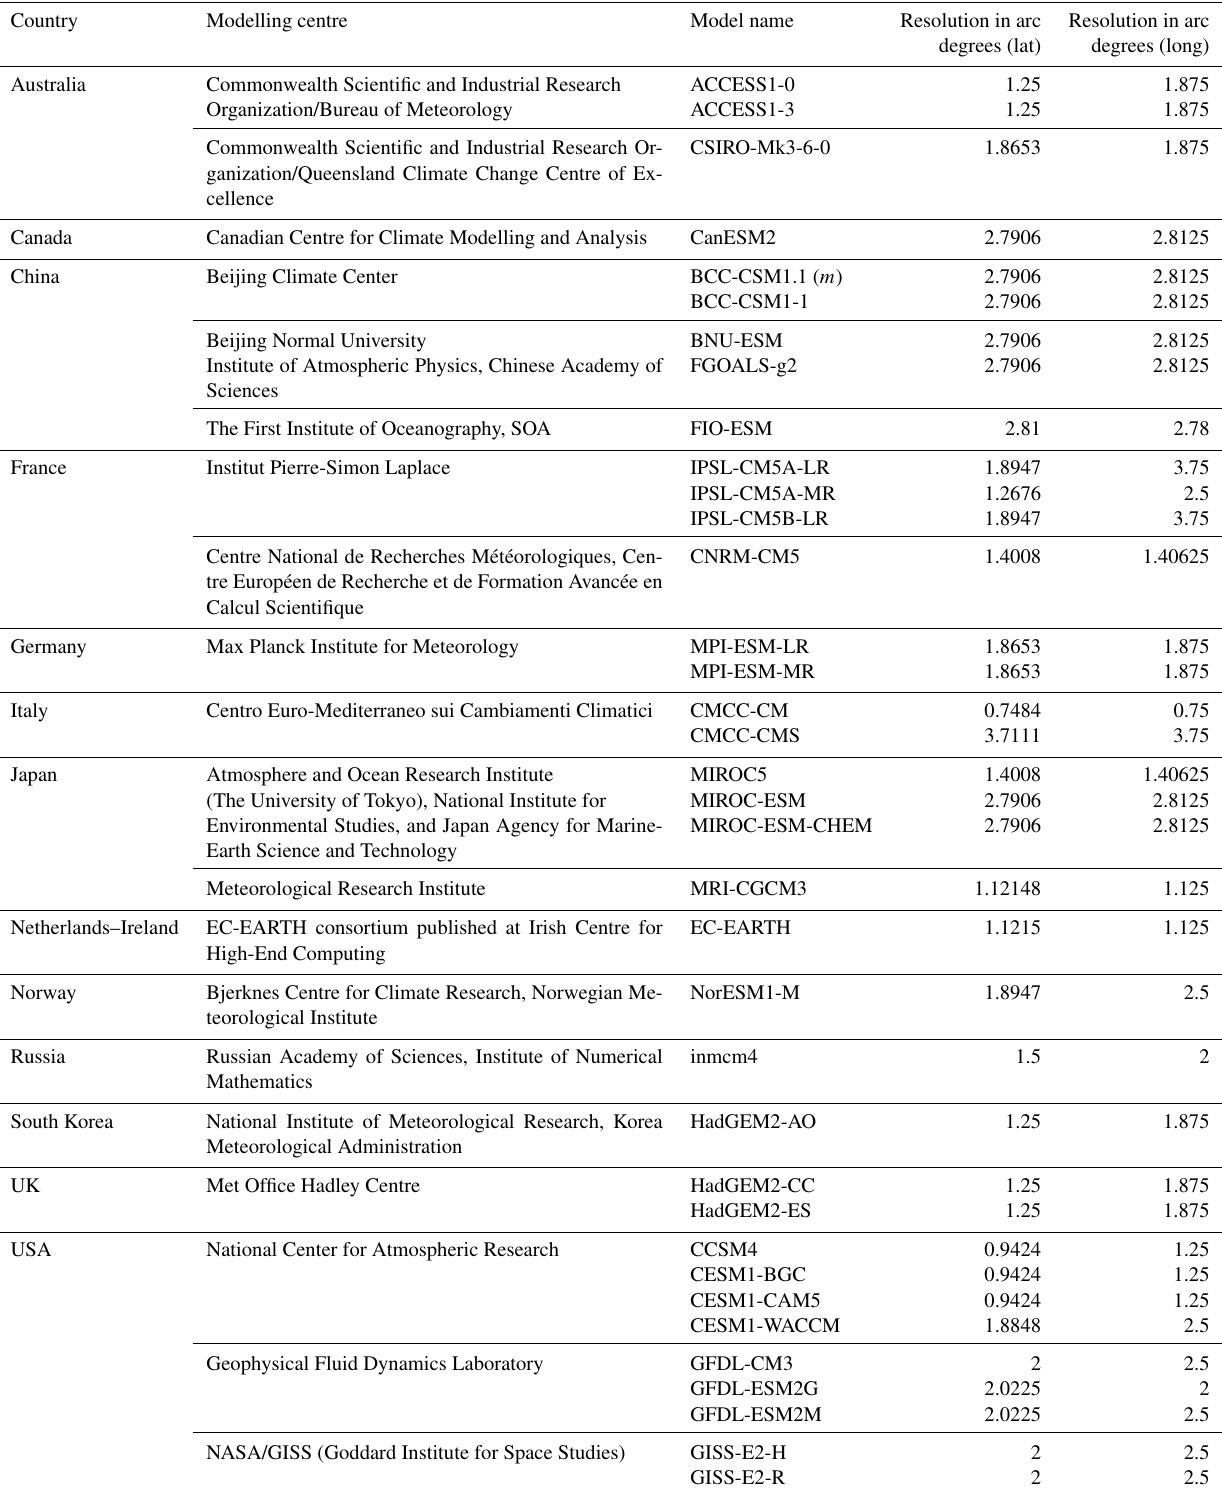
Table 1. CMIP5 GCMs considered in this study.